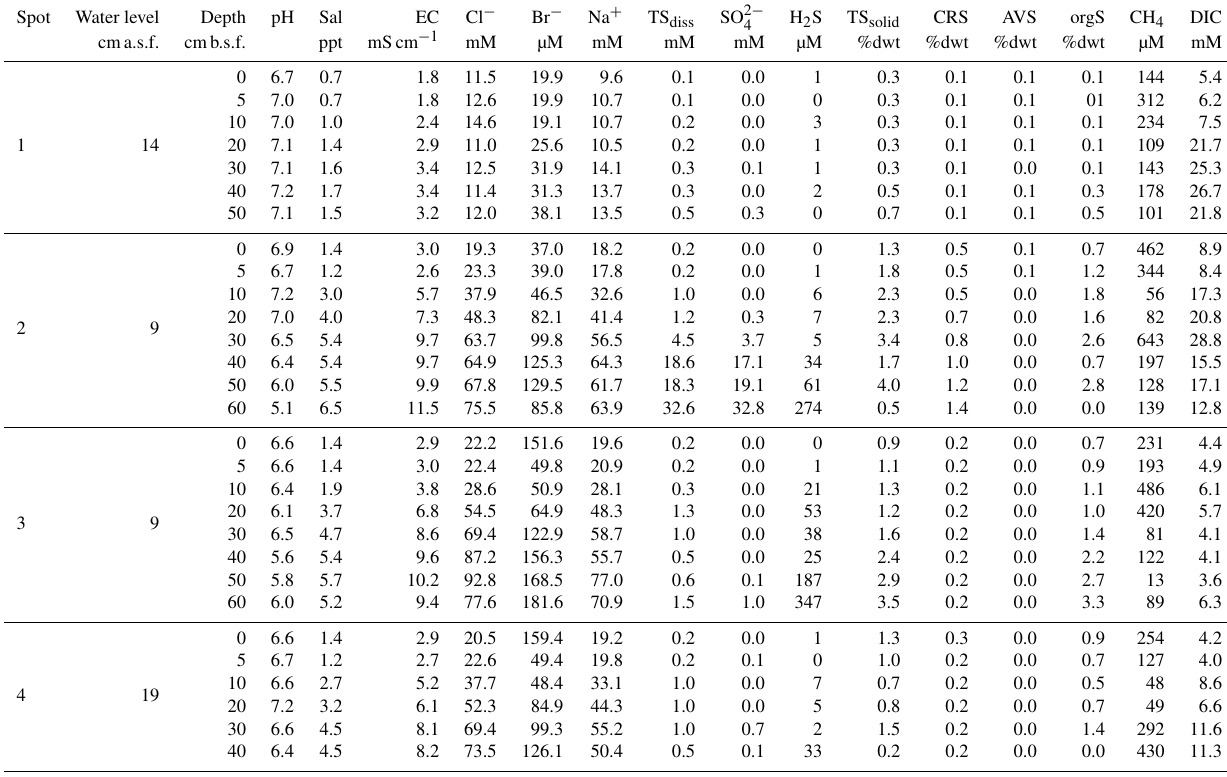
Table A1. Site parameters, pore water, and soil characteristics. Water level and soil depth are given in centimeters above and centimeters below surface (cma.s.f. and cmb.s.f., respectively). Spot Water